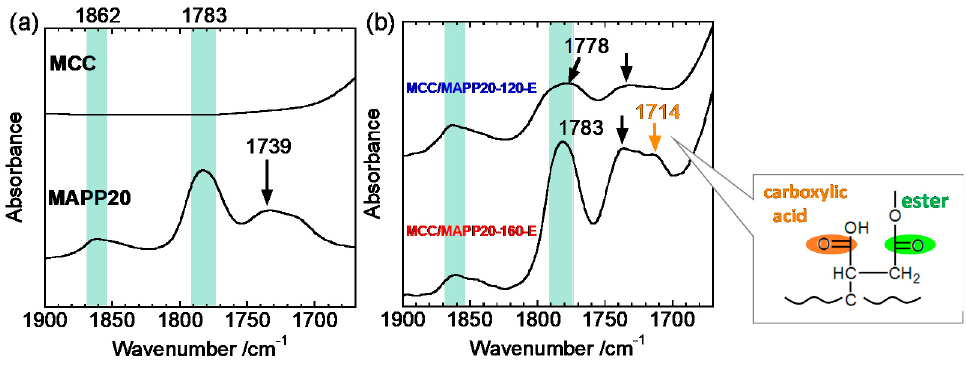
Figure 4. Enlarged view of the carbonyl region of the FTIR spectra of MCC and MAPP20 ( a ) and MCC/MAPP20-E ( b ).